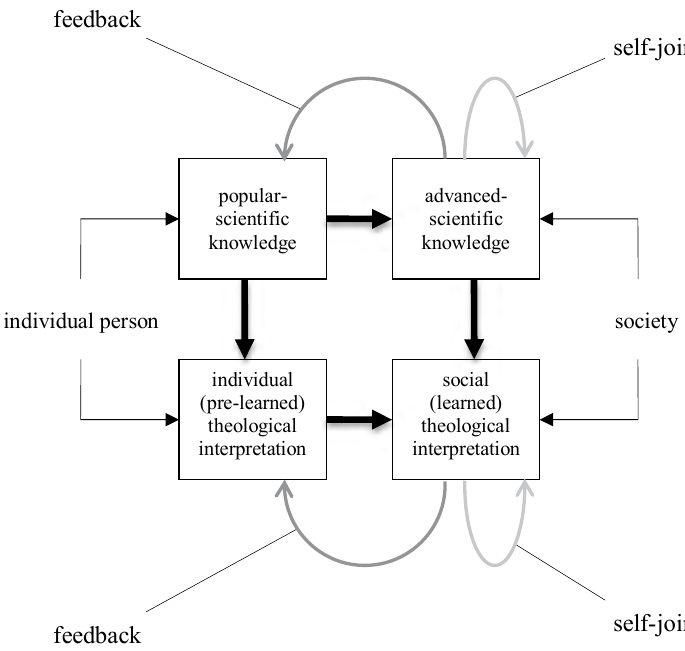
Figure 3: Feedbacks and self-joins in the system epistemology of